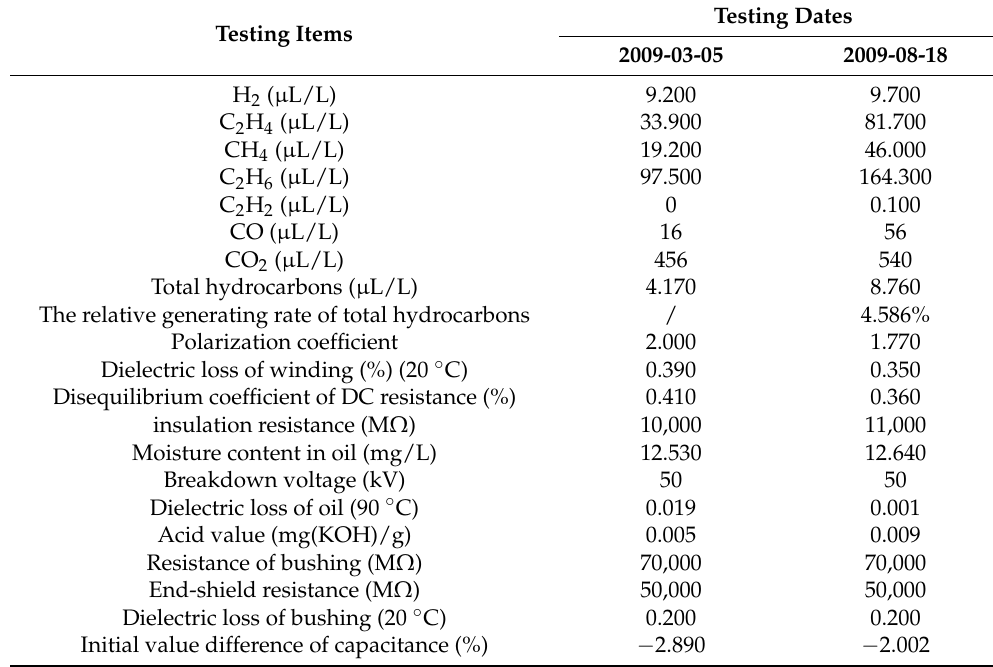
Table 4. Transformer preventive test